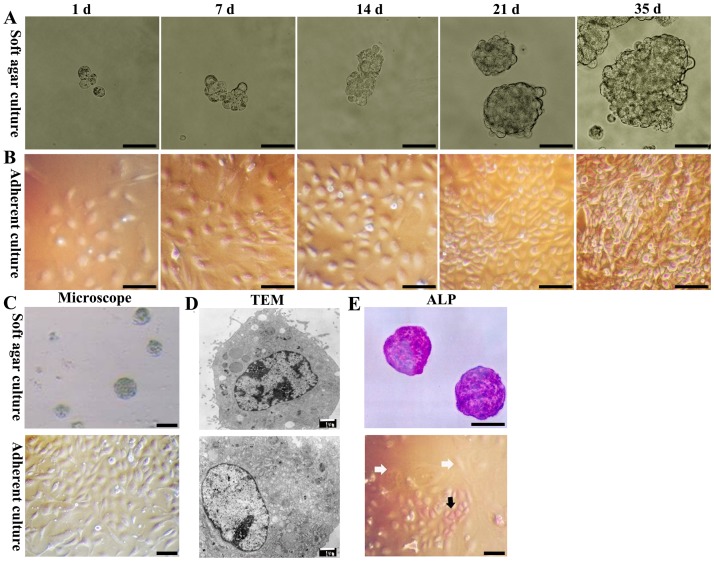
Morphological comparison of FLSPCs in adherent and soft agar cultures.(A) In the soft agar culture, the different-sized cell spheres were formed by FLSPCs at different time intervals, including days 1, 7, 14, 21 and 35. (B) In the adherent culture, FLSPCs form different cell densities at different time intervals, including days 1, 7, 14, 21 and 35. (C) Fourteen days after the initiation of cultures, FLSPCs form cell spheres containing 20–30 cells in soft agar culture. In contrast, large hepatocyte-like cells are found in the adherent culture. (D) As observed by TEM, the FLSPCs within the cell spheres have a high nuclear:cytoplasmic ratio and rich heterochromatin in the nuclei. However, some daughter cells of the FLSPCs taken from the adherent culture show a large diameter and enrichment of cytoplasmic organelles. (E) More than 90% of the FLSPCs within the cell spheres stain purple as ALP-positive cell spheres. Most of the adherent cultured FLSPCs are not stained purple (white arrows), and only 10% of the FLSPCs are stained purple (black arrow). Scale bar: 50 µm (A, B, C and E), 1 µm (D).